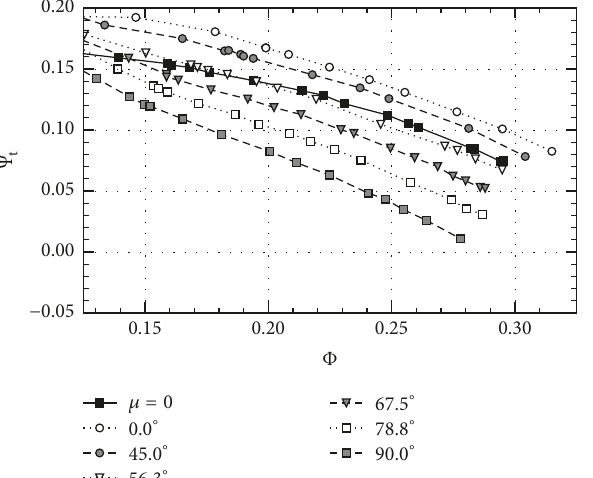
Figure 9: Fan A FD-SI-GG total fan pressure at 𝜇 = 0.25 and different 𝛾